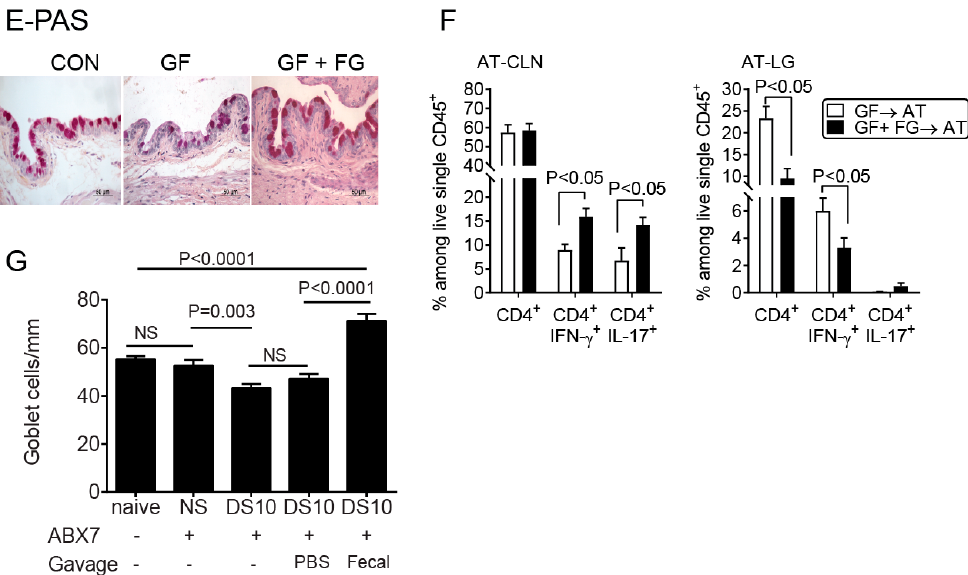
Figure 5. Reconstitution of germ-free mice with commensal bacteria reverses the dry eye phenotype. ( A – C ) Four-week-old female germ-free mice were colonized with a fecal slurry from normal mice (a pool of three mice) by intragastric gavage and sacrificed at eight weeks of age (germ-free + Fecal gavage, GF + FG). ( A ) Comparison of α diversity between starting inoculum (C57BL/6J) and germ-free conventionalized mice ( n = seven) using measures of observed OTUs and Shannon’s diversity index; ( B ) Relative abundance of major bacterial phyla in the starting inoculum (C57BL/6J pool) used to conventionalize mice and in the gut microbiota from conventionalized germ-free mice that received fecal gavage ( n = seven) at eight weeks of age; ( C ) Corneal Oregon-Green dextran fluorescence intensity score. Bar graphs show means ± SEM of two independent experiments with four animals per experiment (final n = eight animals, female sex). Mann-Whitney U comparison test; ( D ) Number of PAS + conjunctival goblet cells counted in paraffin-embedded sections expressed as number per millimeter. Bar graphs show means ± SEM of two independent experiments with three-four animals per group, yielding a final sample of seven right eyes for each group). Mann-Whitney U comparison test; ( E ) Representative images of conjunctiva sections stained with PAS used to generate the bar graph in ( D ); ( F ) Flow cytometry analysis showing the percentage of total CD4 + , Th1 (CD4 + IFN- γ + ), Th17 (CD4 + IL-17 + ) cells in freshly isolated cervical lymph nodes (CLN) and lacrimal glands (LG) in adoptive transfer ( → AT) recipients of either germ-free or germ-free + FG CD4 + T cells. Each experiment group consisted of three-to-four samples; showing means ± SEM of two independent experiments, yielding a final sample of seven to eight per group. Mann-Whitney U comparison test; ( G ) Fecal transplant during desiccating stress (DS) rescues goblet cells. Female conventional C57BL/6 mice were left untreated (naïve mice) or received a cocktail of antibiotics (ABX) for seven days. On the morning of the 8th day, mice were switched to normal water and subjected to desiccating stress (DS) for ten days (DS10) and randomized to receive either PBS or oral gavage of fecal material or were left non-stressed. Mice under DS were sacrificed after ten days, and the number of PAS + cells in the conjunctiva was determined. n = five animals/group. Kruskal-Wallis test followed by Tukey’s post hoc test. NS = non-significant.